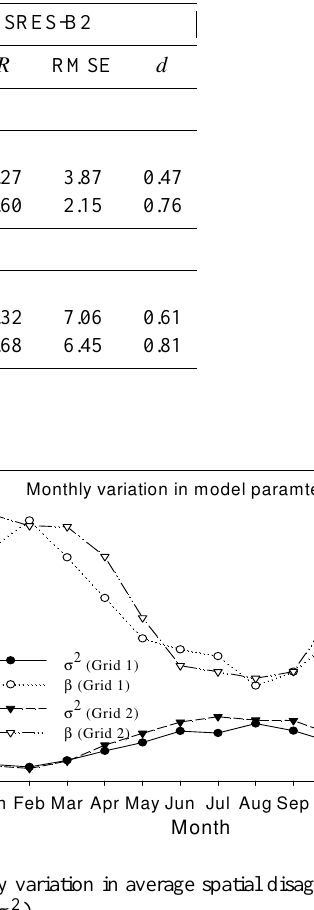
Table 1. Performance of bias-correction method on monthly rainfall amount.